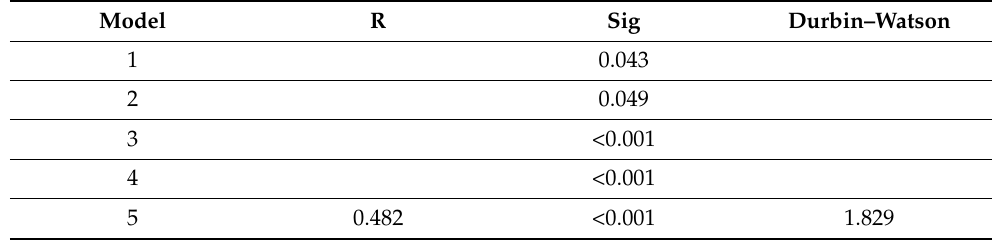
Table 3. Summary of the general model.